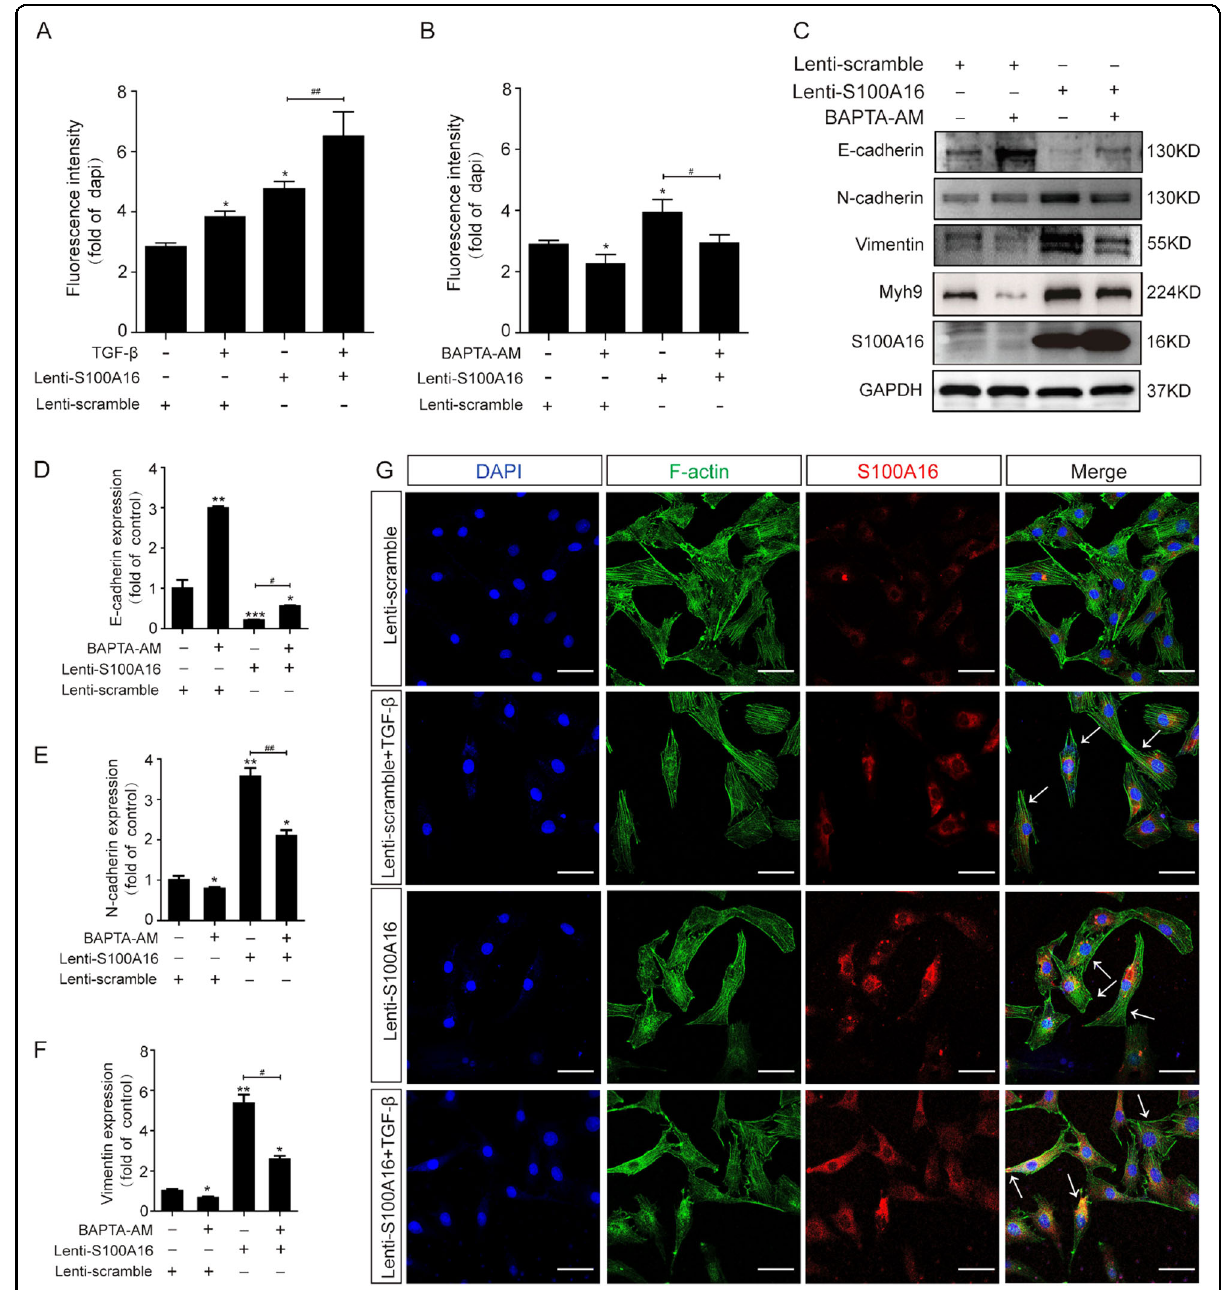
Fig. 7 Increased S100A16 expression in HK-2 cells drives Ca 2 + accumulation in the cytoplasm and promotes cytoskeleton reorganization. a , b Normal and S100A16-overexpressing HK-2 cells were treated with TGF- β (20 ng/ml) or BAPTA-AM (10 µM), and the intracellular calcium concentration was measured using Rhod-2 AM, a fl uorescent Ca 2 + indicator probe. c – f . Representative bands of western blots are shown for the expression of Myh9, E-cadherin, N-cadherin, vimentin, and S100A16 in normal and S100A16-overexpressing HK-2 cells after BAPTA-AM treatment. * p < 0.05, ** p < 0.01 vs. scrambled; # p < 0.05, ## p < 0.01. g Representative images showing the reorganization of F-actin protein in S100A16- overexpressing HK-2 cells after treatment with TGF- β (20 ng/ml) (arrows, cytoskeleton remodeling HK-2 cells). Scale bar = 20 μ